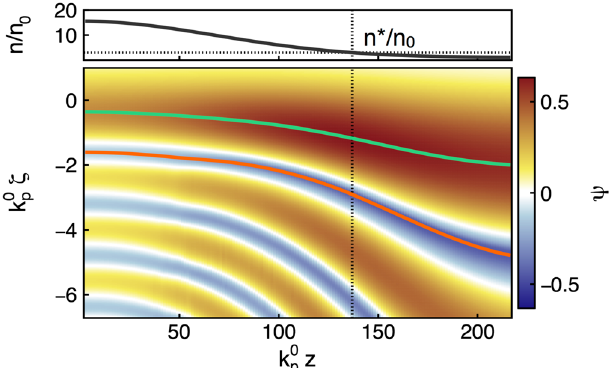
FIG. 4. Evolution of the on-axis wakefield potential (bottom) along a Gaussian DDR ( k 0 p σ l ¼ 68 . 5 ) (top) for a beam with ¼ 2 . 5 kA. ~ n ¼ 15 . 63 in the simulation and ~ n (cid:2) ¼ 1 þ I 0 b top ð ~ n − 1 Þ = exp ð 2 Þ . The vertical dotted line marks the z ¼ 2 σ l top position at which n ¼ n (cid:2) , with n (cid:2) the resonant density. The positions of ψ and ψ are drawn in green and orange, max min respectively. track these positions to obtain ψ and ψ as a function min max of z [Fig. 4 (bottom)], and using ~ n ð z Þ [Fig. 4 (top)], we obtain the dependence of these quantities on the plasma density. Figure 5(a) shows ψ and ψ as a function of ~ n min max for the three simulations with I 0 b ¼ 1 . 0 ; 2 . 5 , and 5.0 kA.